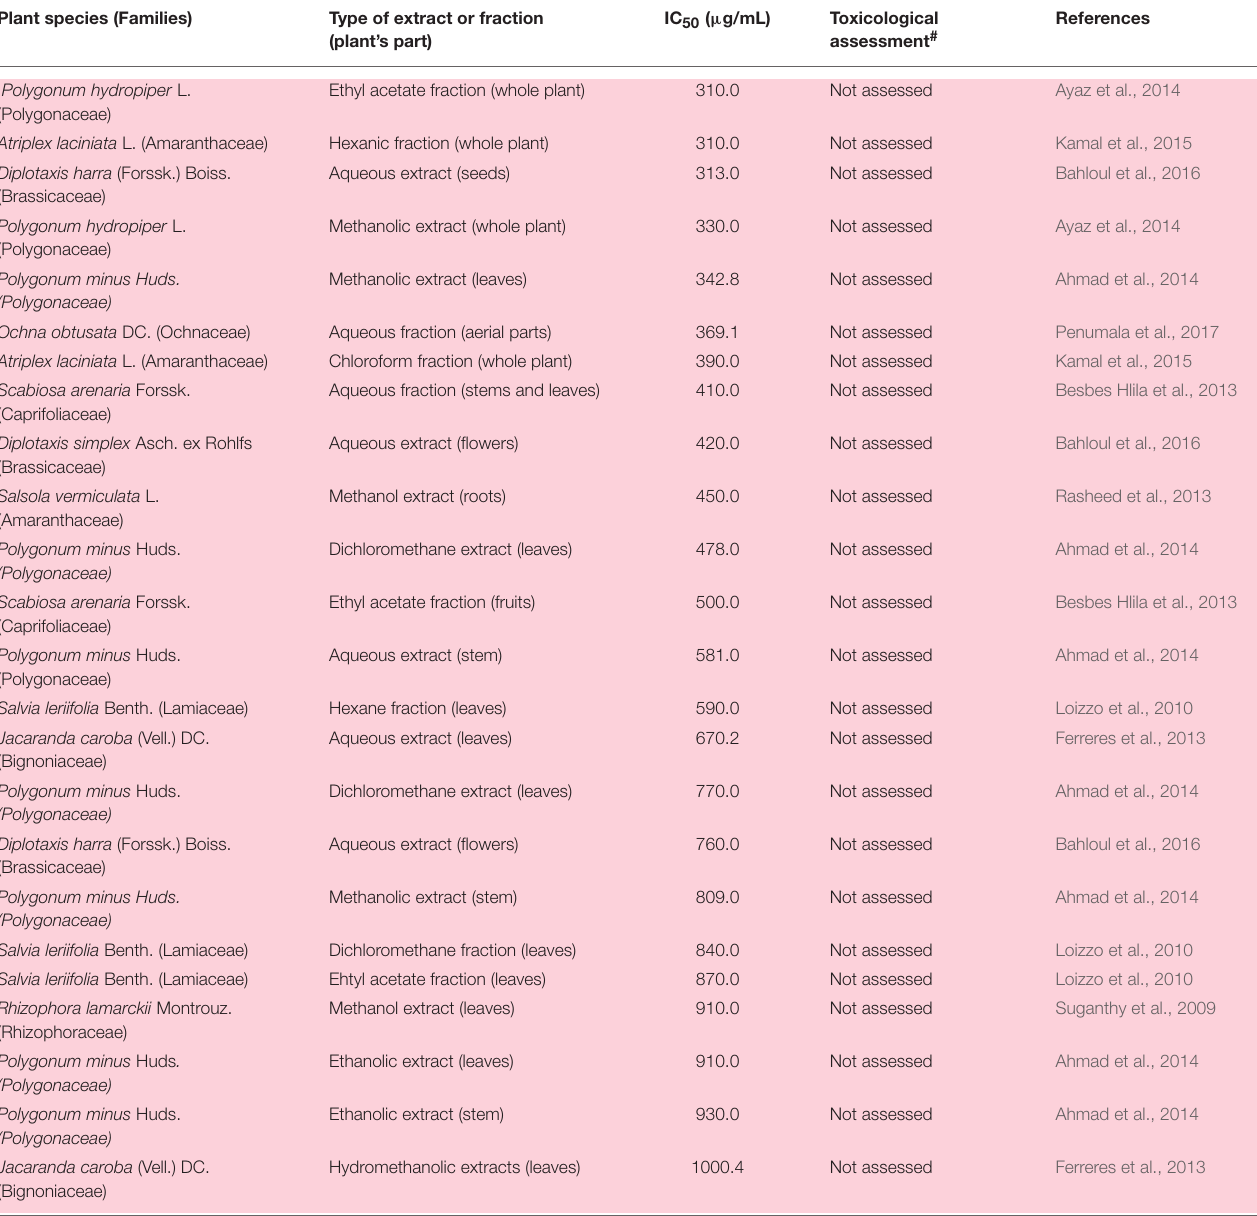
Table 1 ). Both S. puniceus and L. schweinfurthii ethyl acetate extracts showed very-limited antioxidant activity, leading